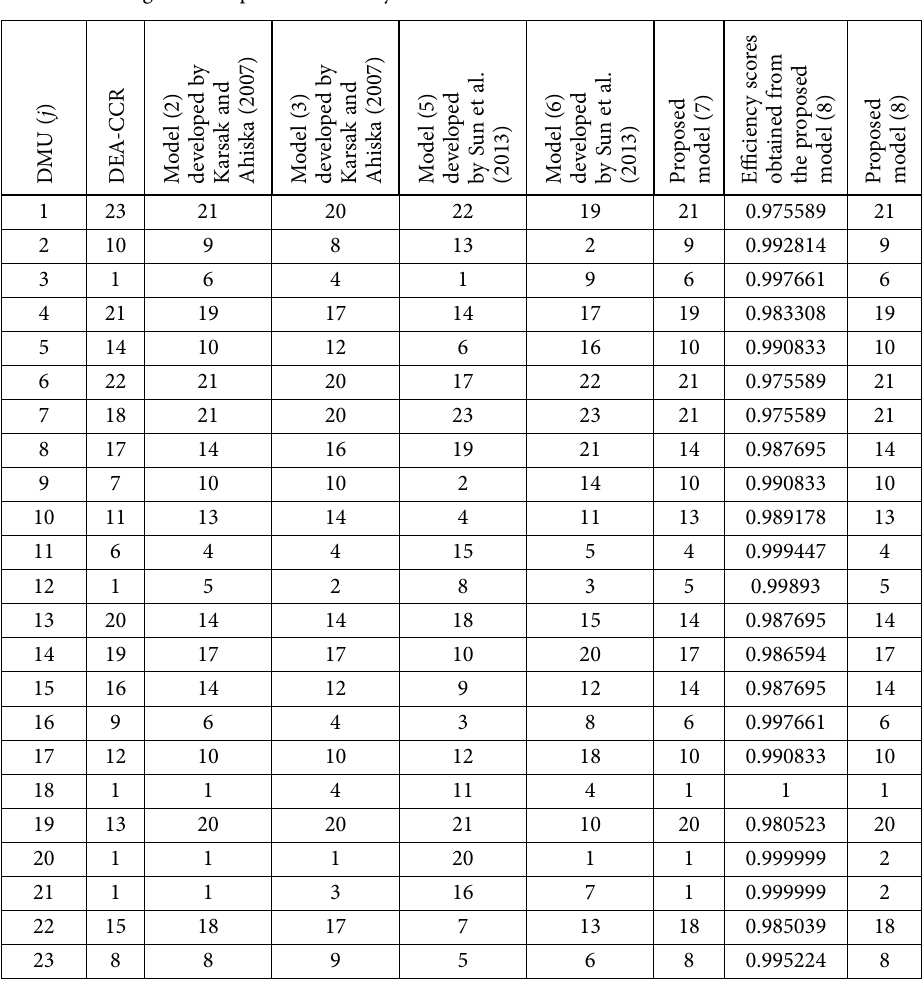
Table 4. Rankings with respect to efficiency scores of countries